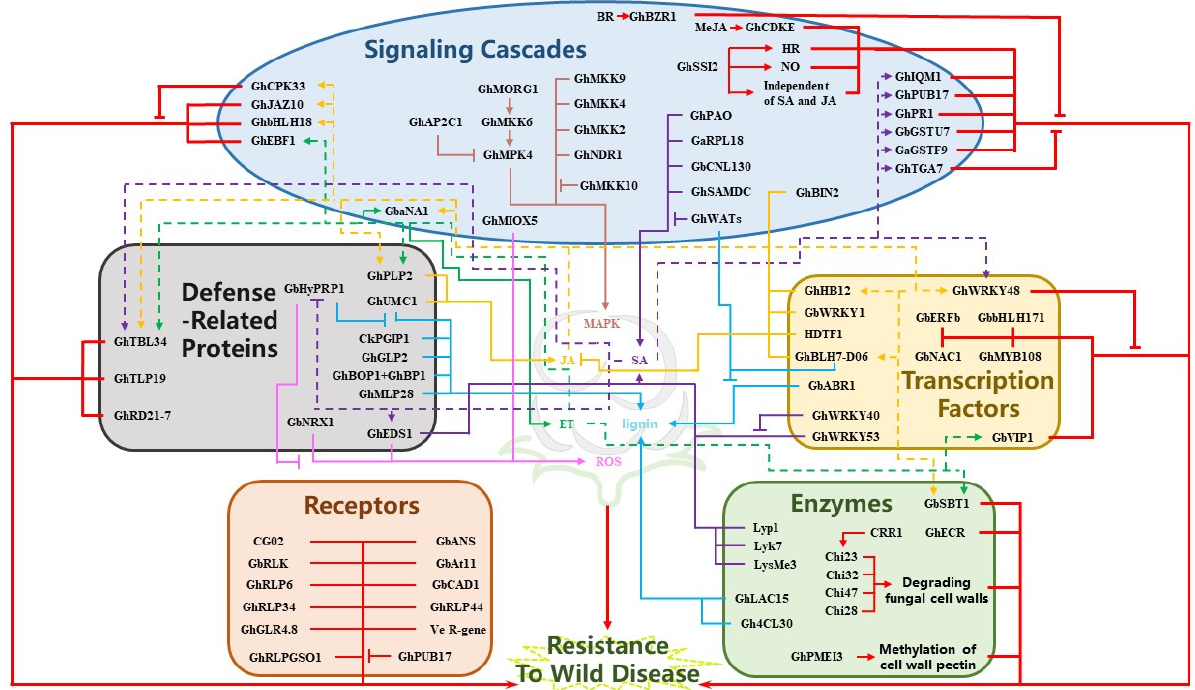
Figure 2. Regulatory network of disease resistance genes in cotton. Solid lines indicate the mechanism by which genes further affect plant disease resistance by acting on JA, SA, ET, lignin, ROS, and MAPK. Dashed lines indicate the mechanisms by which genes are regulated by JA, SA, ET, lignin, ROS, and MAPK to affect plant disease resistance. Blunt ends indicate inhibition. Arrows indicate promotion. Brown, yellow, purple, green, blue, and pink indicate MAPK, JA, SA, ET, lignin, and ROS interactions with these genes, respectively. Red indicates unclear